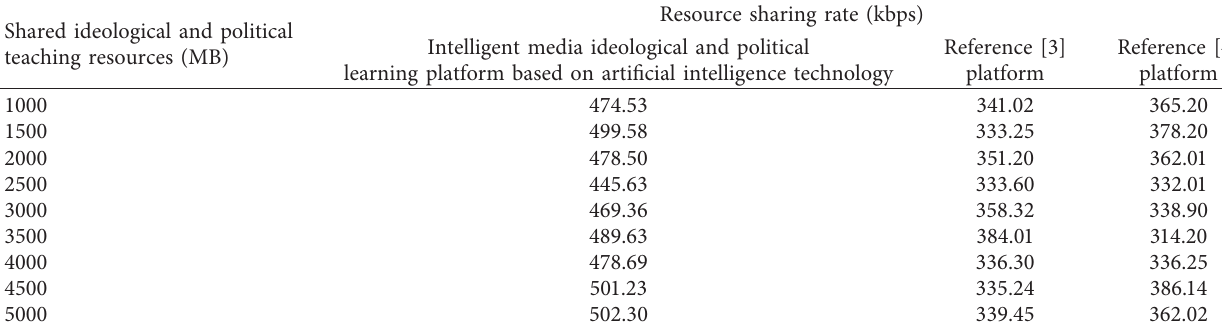
Table 2: Comparison of experimental data of resource sharing